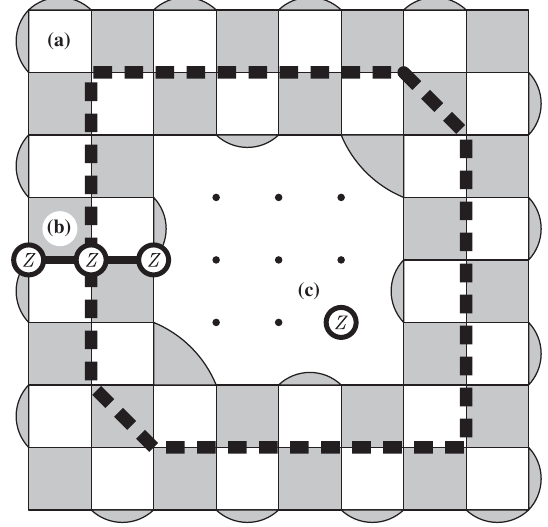
FIG. 2. A hole in the planar code modifies its code space. A hole is shown in the center of the lattice. (a) When a hole is prepared, a new logical operator is produced which consists of a nontrivial cycle of Pauli- X operators that enclose the hole. The qubits that support the logical operator are marked by a thick dashed line. (b) The logical operator shown by label (a) anti- commutes with the conjugate logical operator which is composed of the tensor product of Pauli- Z operators that extends from the boundary of the hole to the boundary of the surface. (c) A hole can be produced in the lattice by measuring the qubits in the computational, i.e., Pauli- Z ,